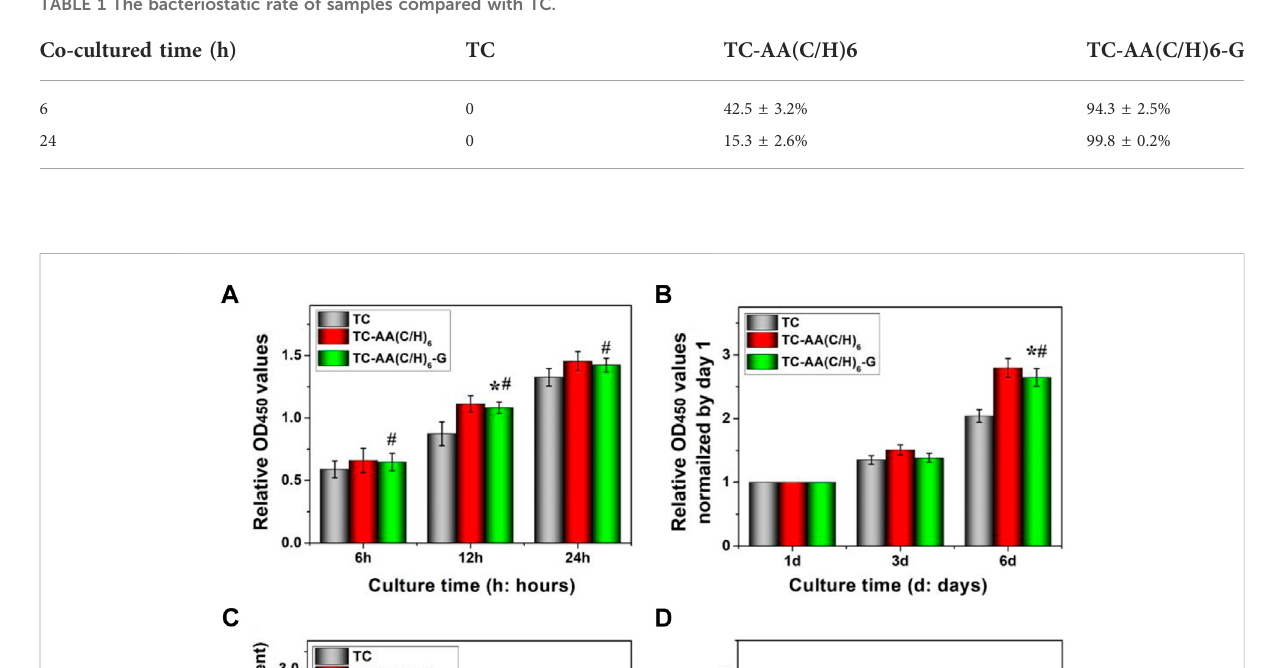
TABLE 1 The bacteriostatic rate of samples compared with TC.